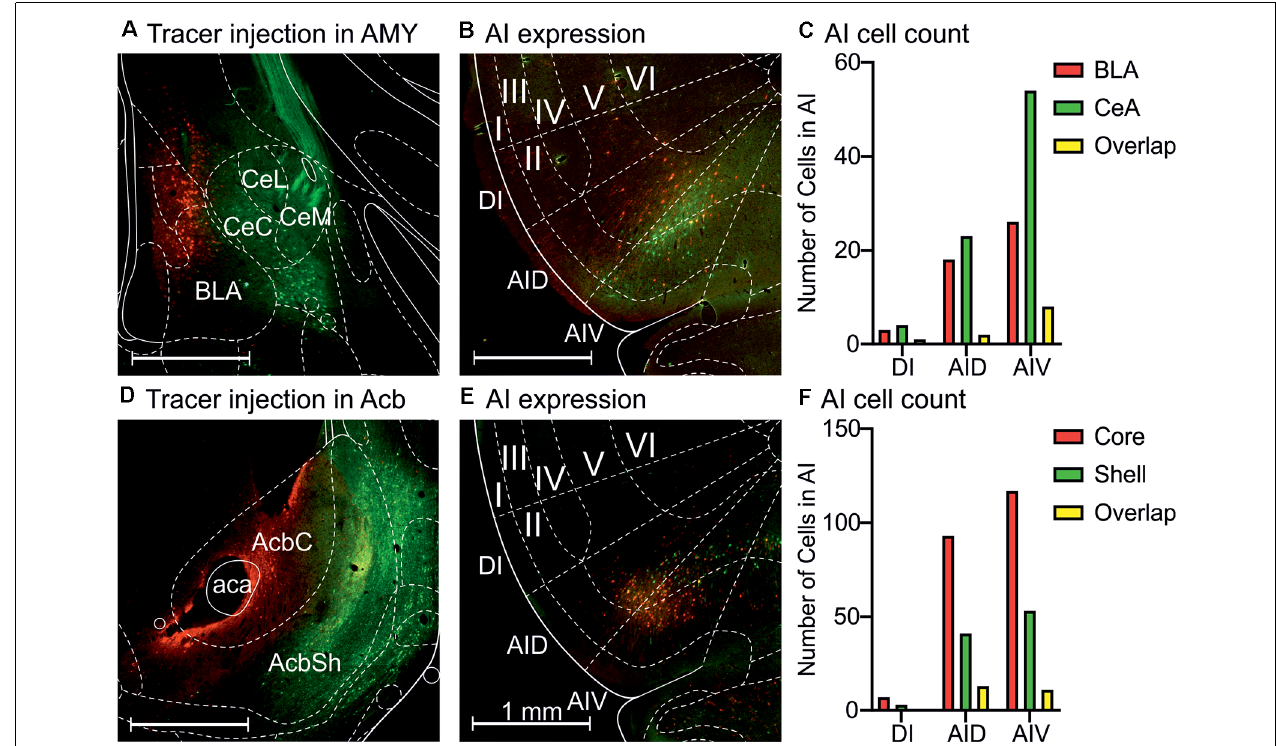
FIGURE 5 | Retrograde tracing with AAV2-retro vectors shows populations of anterior insula neurons projecting to the amygdala and nucleus accumbens subdivisions. (A) Starter neurons in the central amygdala (GFP) and BLA (mCherry). (B) Retrogradely labeled neurons in the agranular insula. (C) Quantification of the DI, AID, and AIV neurons projecting to central (CeA) and basolateral (BLA) amygdala. (D) Starter neurons in the nucleus accumbens core (mCherry) and shell (GFP). (E) Retrogradely labeled neurons in the agranular insula. (F) Quantification of the DI, AID, and AIV neurons projecting to nucleus accumbens core and shell. Abbreviations used: DI, dysgranular anterior insula; AID, agranular anterior insula, dorsal; AIV, agranular anterior insula, ventral; CeC, central amygdaloid nucleus, capsular division; CeL, central amygdaloid nucleus, lateral division; CeM, central amygdaloid nucleus, medial division; BLA, basolateral amygdala; AcbC, nucleus accumbens core; AcbSh, nucleus accumbens shell; aca, anterior commissure. The Roman numerals refer to cortical layers